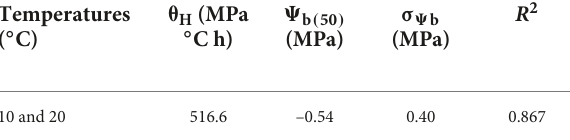
TABLE 3 Model parameters for the hydrothermal time model describing germination of Parthenium hysterophorus seeds under controlled environment (lab